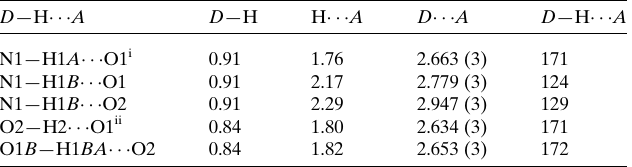
Table 2 Hydrogen-bond geometry (A˚ , (cid:3) ).